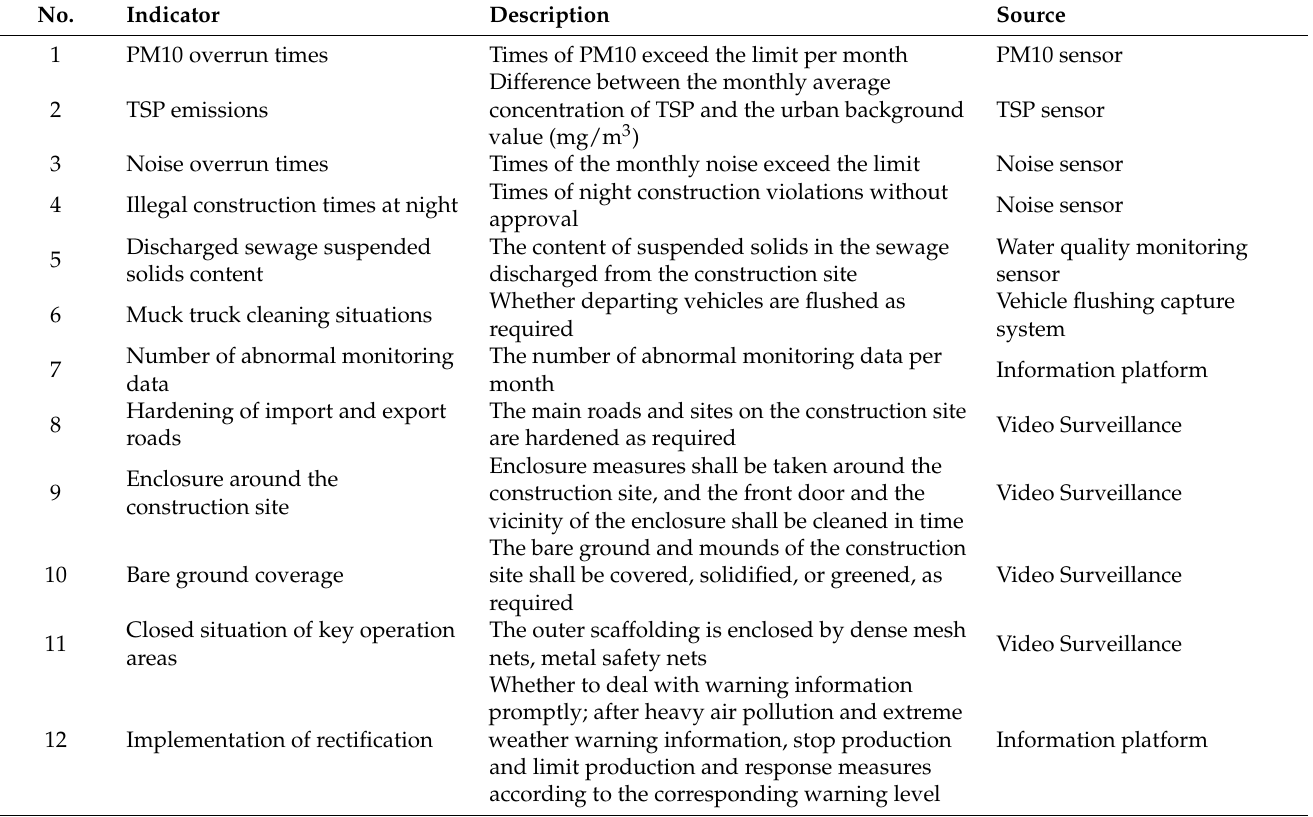
Table 3. The environmental monitoring and evaluation indicator